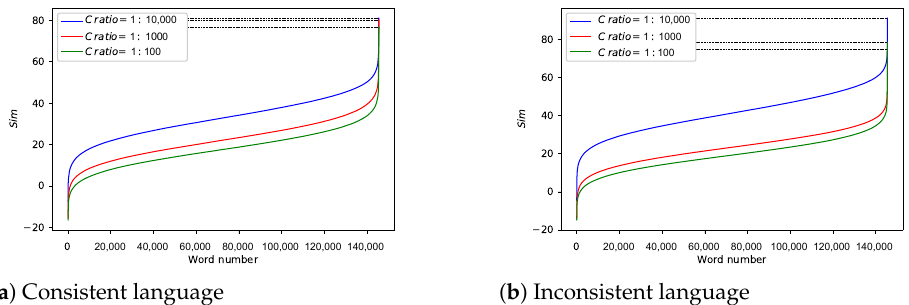
Figure 13. Correlation (measured by sim ) as C ratio changes.